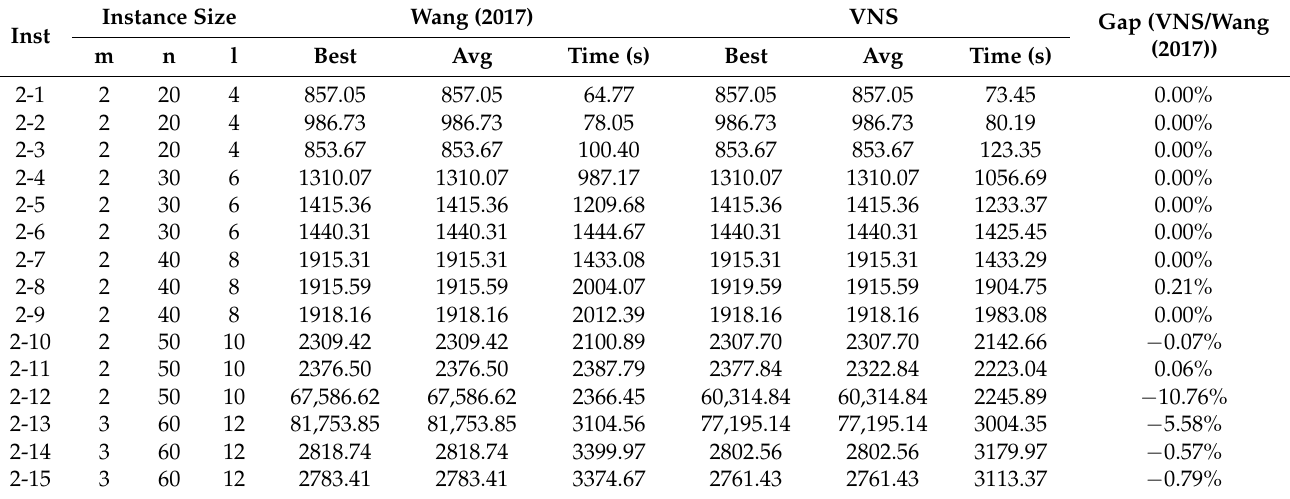
Table 4. Results for the middle-sized instances.